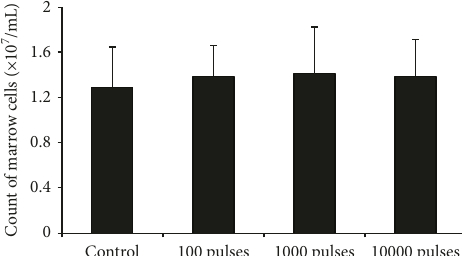
Figure 2: Changes of bone marrow nucleated cell number in mice after exposed to PEMF at di ff erent pulses. The bone marrow cells were fl ushed from the left femur with 1 mL of RPMI-1640 medium supplemented with 10% heat-inactivated fetal bovine serum. The number of nucleated cells was determined by cell counting. All data were presented as mean ± SD